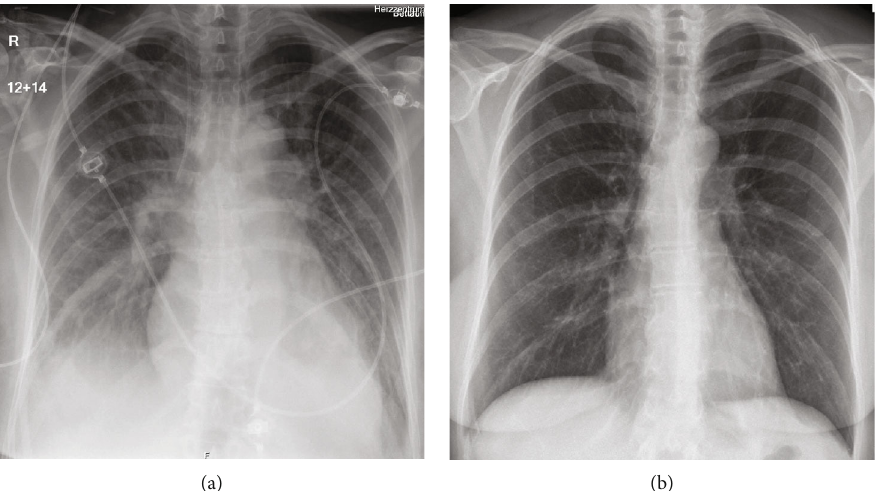
Figure 2: Chest X-ray on admission (a) showing signs of heart enlargement and pleural e ff usion. Six days later before discharge (b), the heart size is normal again, and there is complete remission of pleural e ff